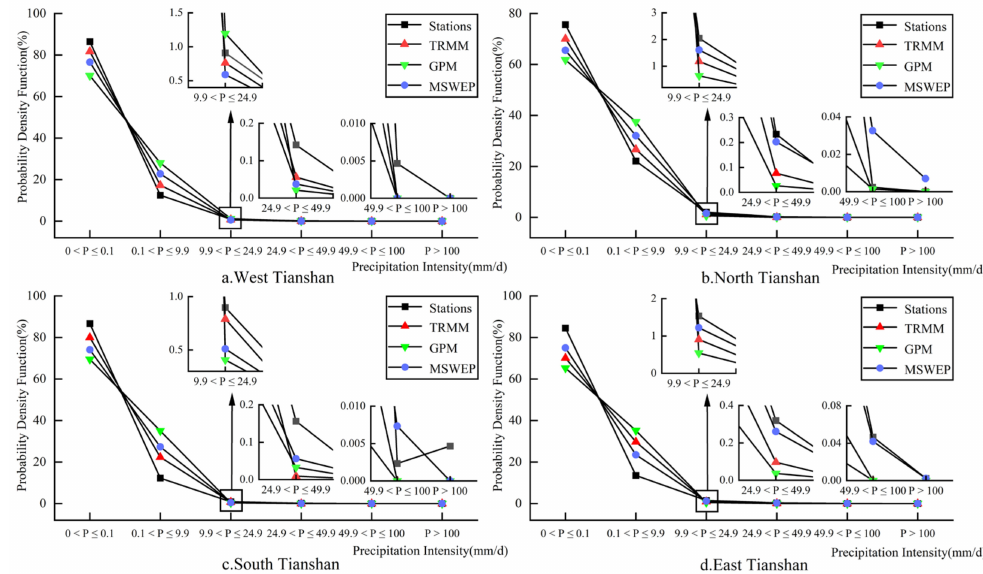
Figure 6. Frequency distribution of daily precipitation of different magnitudes in ( a ) West Tianshan, ( b ) North Tianshan, ( c ) South and ( d ) East Tianshan.